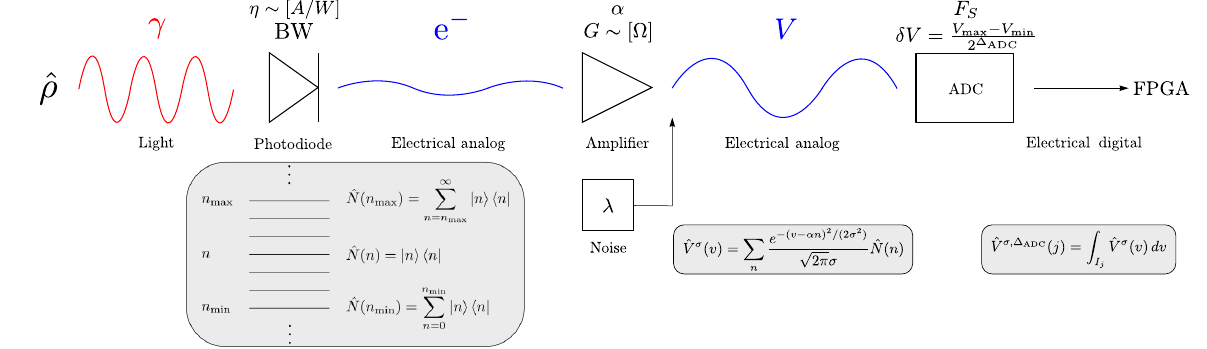
FIG. 6. Detector model. Photons from a photonic state ˆ ρ impinge onto a photodiode whose linear range and equivalent L photon projectors are given in Eq. (B1). The photodiode ’ s voltage response is given by the conversion factor α expressed in Eq. (B8) in general and Eq. (B11) in our case. This factor incorporates the photodiode ’ s bandwidth BW, its responsitivity η (in A W − 1 ), and the transimpedence gain G . Noise characterized by a Gaussian random variable λ is then added onto the voltage, leading to the voltage POVM in Eq. (B12). Finally, the voltage is discretized by an ADC with effective resolution δ V and at a sampling rate F POVM associated with the measurement of the j th voltage bin expressed in Eq. (B20). Light has been effectively converted from photons to a digital electrical signal which one can subsequently feed to an